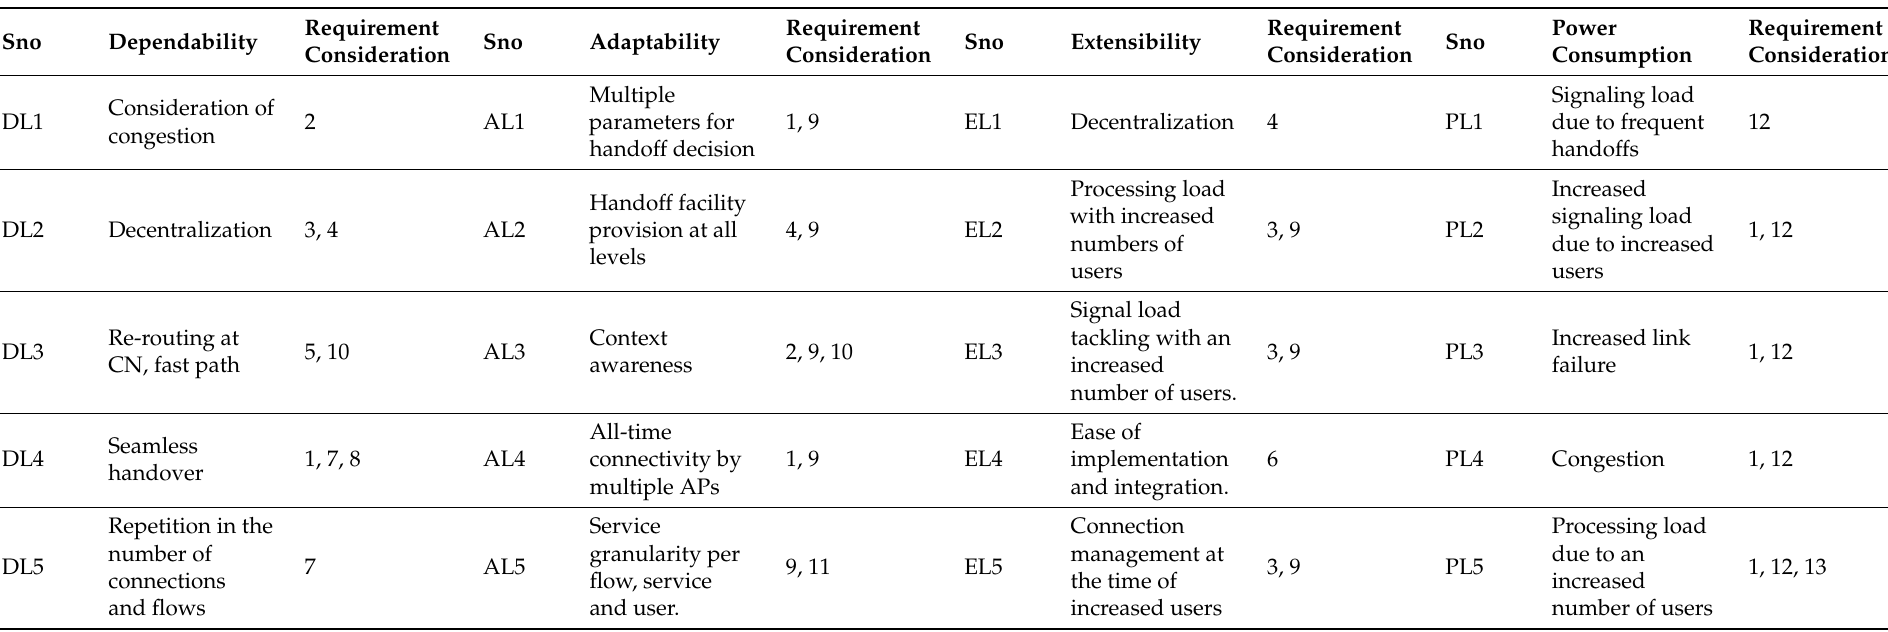
Table 2. Major parameters for the dependability, adaptability, extensibility, and power consumption of a MM